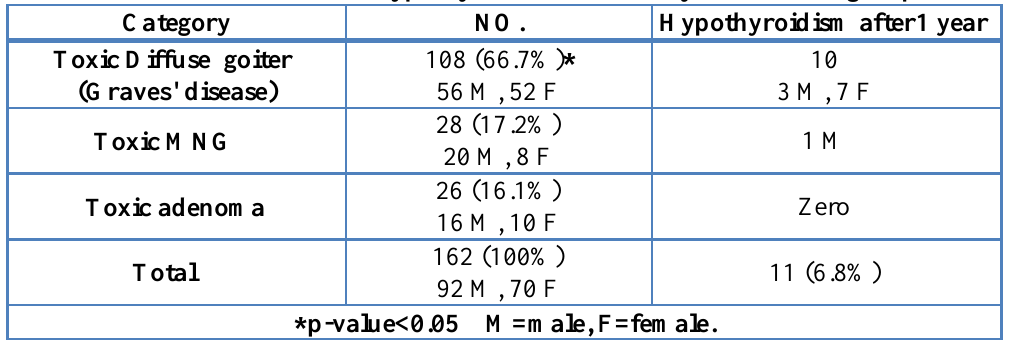
Table 2: The evidence of hypothyroidism after one year in the 1 st